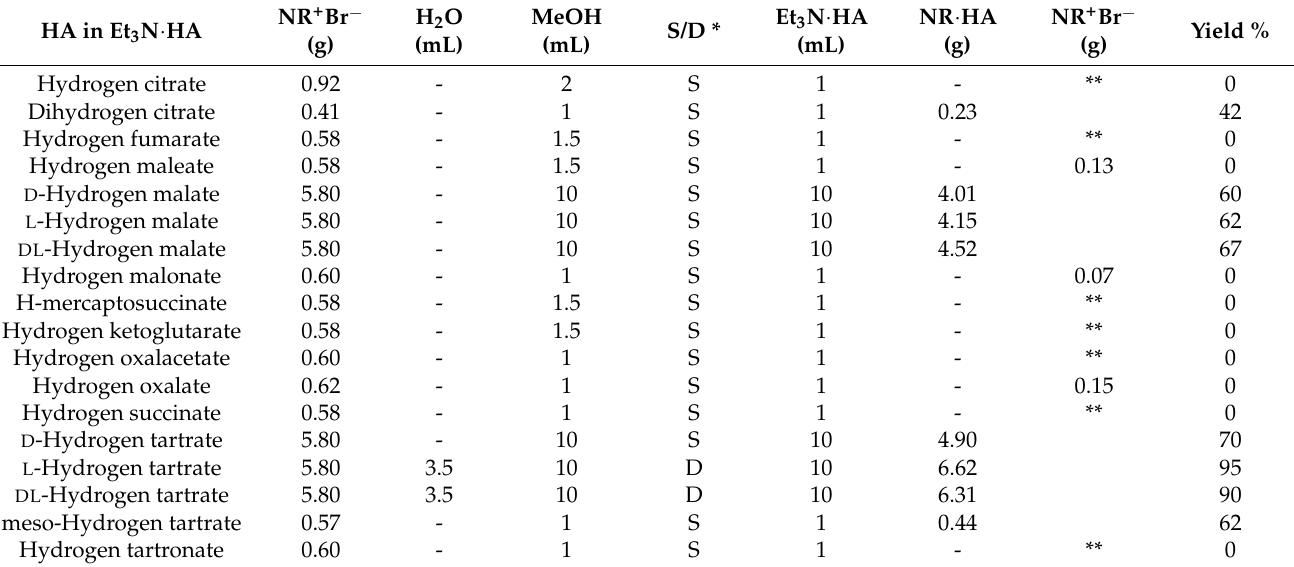
Table 2. Salt metathesis results with NR + acidic